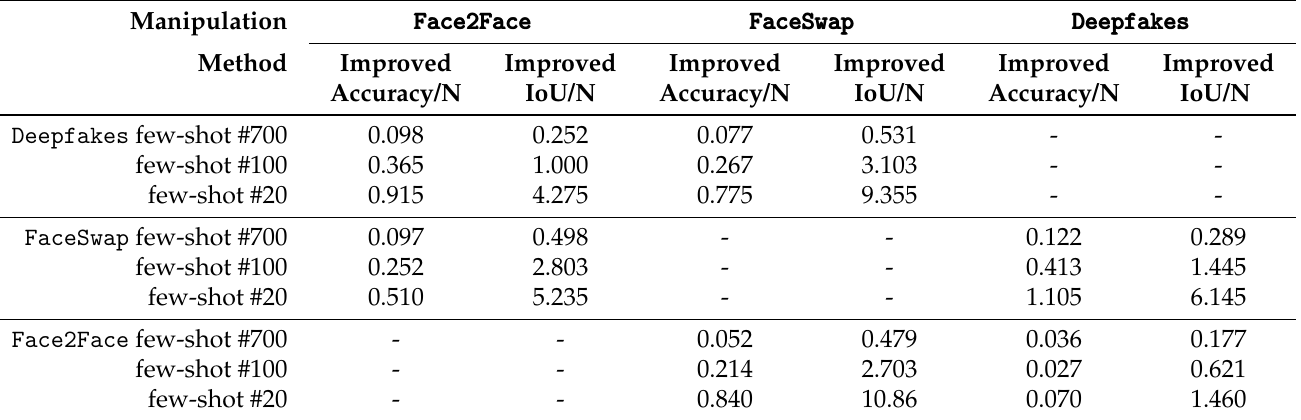
Table 8. Improvement per sample in few-shot learning for detecting C23 crop images altered by Face2Face , FaceSwap , and Deepfakes manipulation methods with difference-based models. In the presented table, the variable N represents the quantity of fine-tune samples.